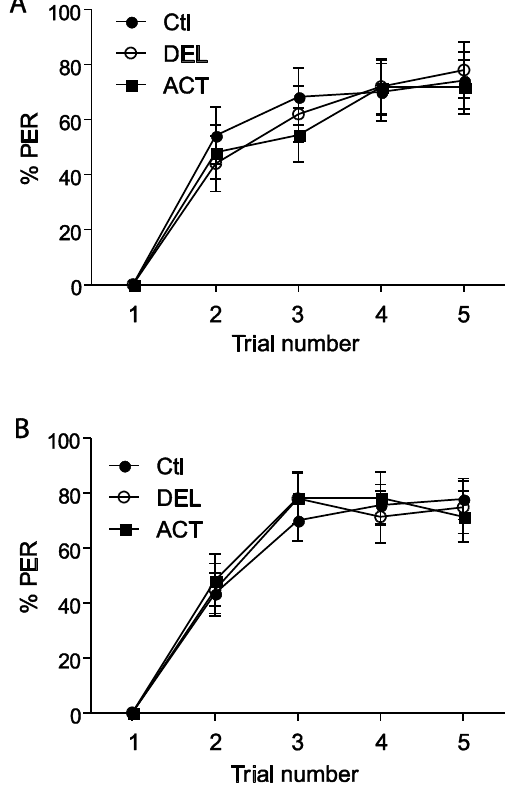
Figure 2. PER responsiveness of honey bees when drugs were applied 24 h before learning sessions. ( A , B ) bees treated with 10 ng or 100 ng of ACT or DEL, respectively. The learning performance is expressed as the percentage of PER to antennal stimulation with 40% sucrose solution. Each group represents n = 90 bees. Bars represent standard